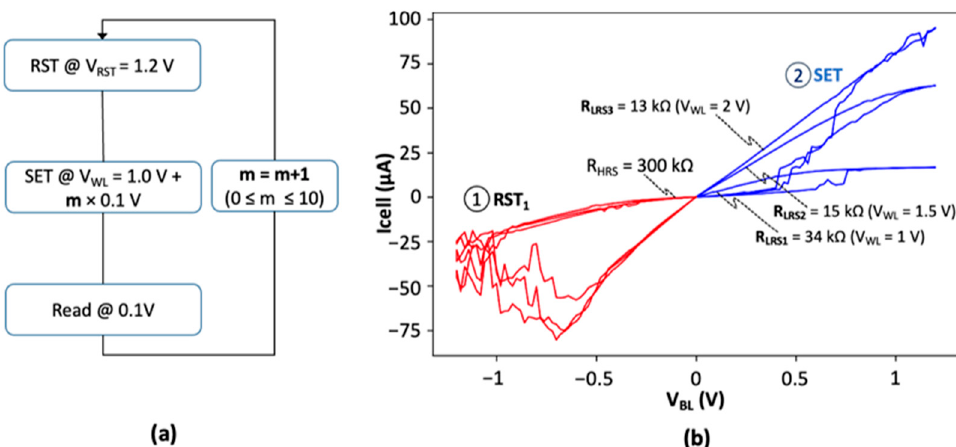
Figure 10. ( a ) R LRS conductance variation measurement protocol and ( b ) R HRS vs. V WL for 3 different V WL values (1 V, 1.5 V and 2 V).